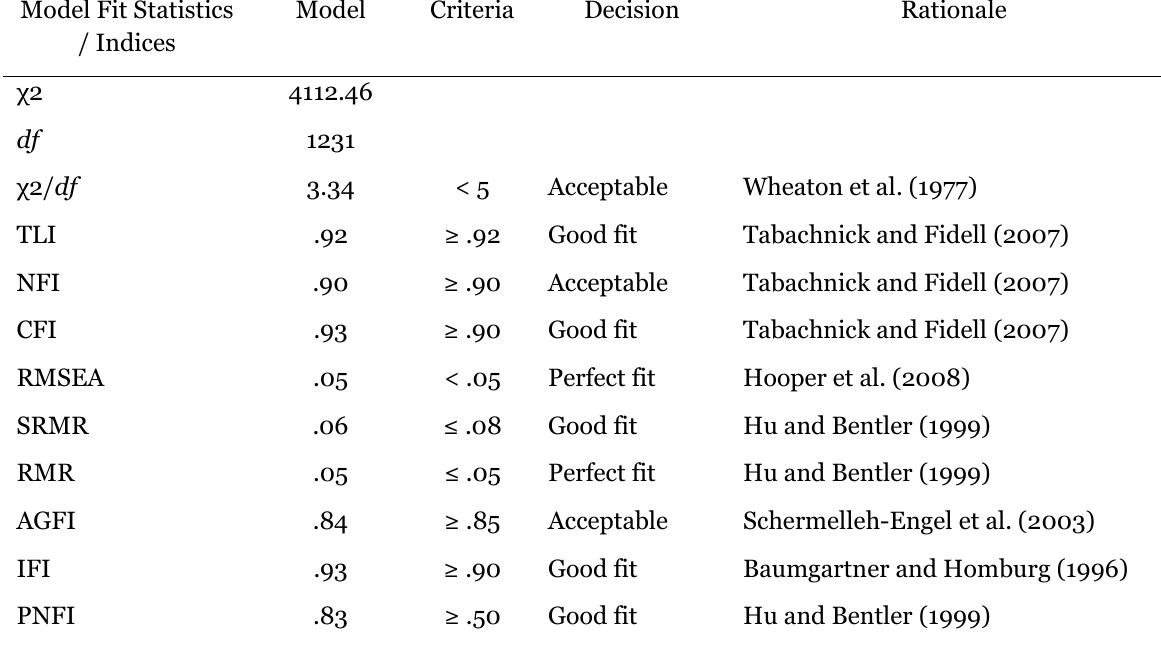
Model Fit Measurements Model Fit